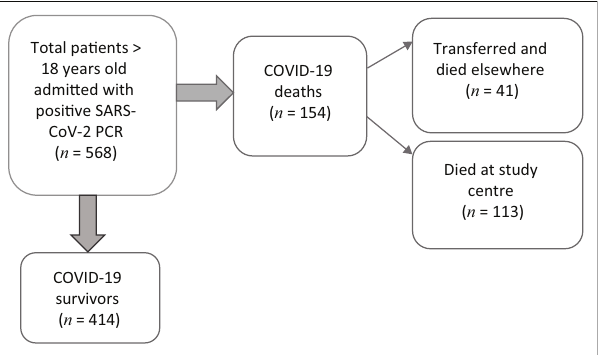
FIGURE 2: Flow diagram detailing number of patients admitted, survived and